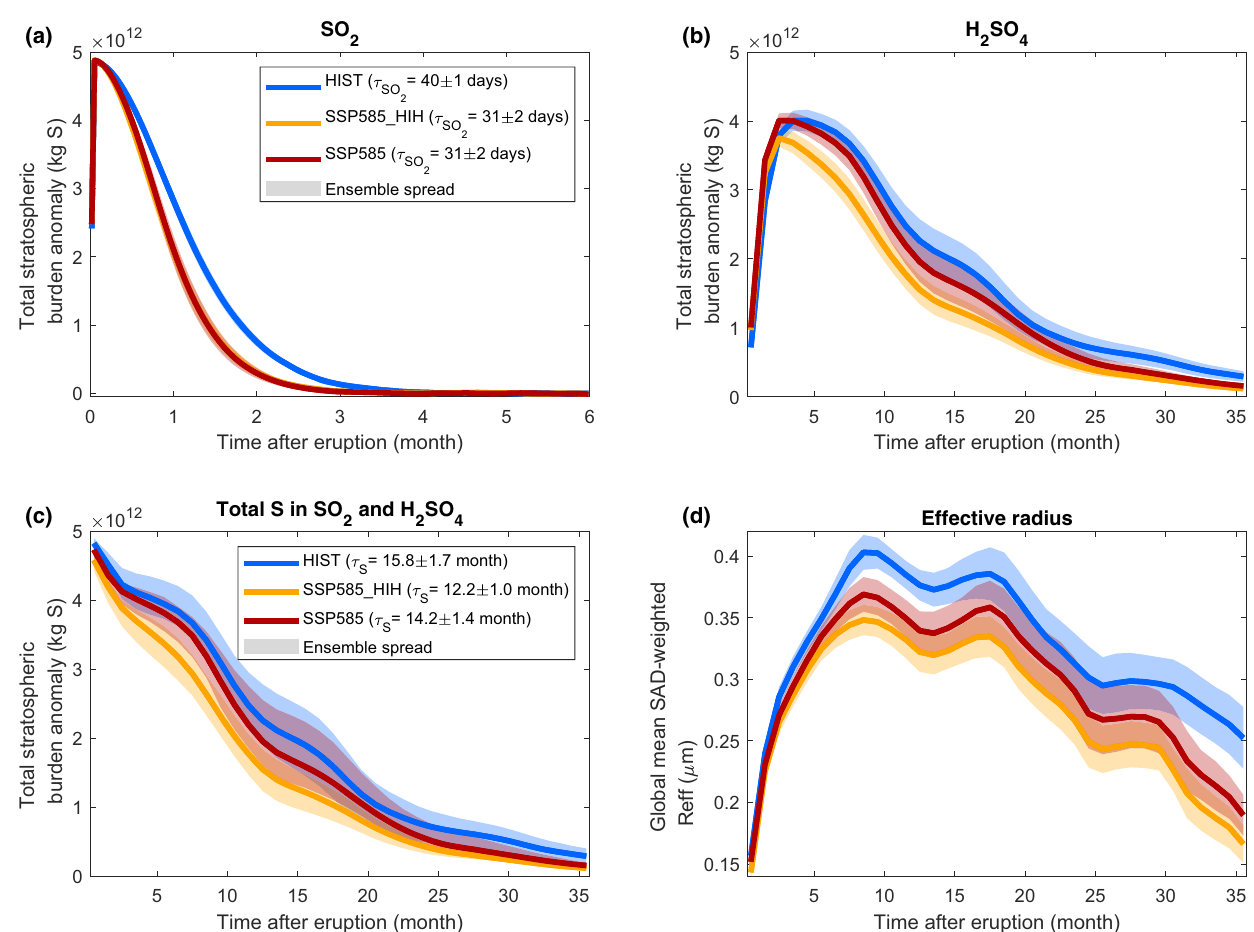
Fig. 5 Temporal evolution of the global-mean stratospheric S budget (Tg S) and the global-mean sulfate aerosol effective radius (Reff in μ m) for the large-magnitude eruption. Time series of total stratospheric burden anomalies of SO 2 ( a ), H 2 SO 4 ( b ), and S ( c ). Panel d shows the stratospheric global- mean surface area density-weighted effective radius time series. The different colors correspond to the different scenarios. All panels are for the large- magnitude eruption. The SO 2 time series is a daily mean, all other ones are monthly means. See Methods section for de fi nitions of the SO 2 and total S e- folding time provided. The HIST scenario represents the historical climate and the SSP585 scenario is an upper-end future climate scenario. SSP585_HIH is as SSP585 but uses SO 2 injection heights consistent with the HIST